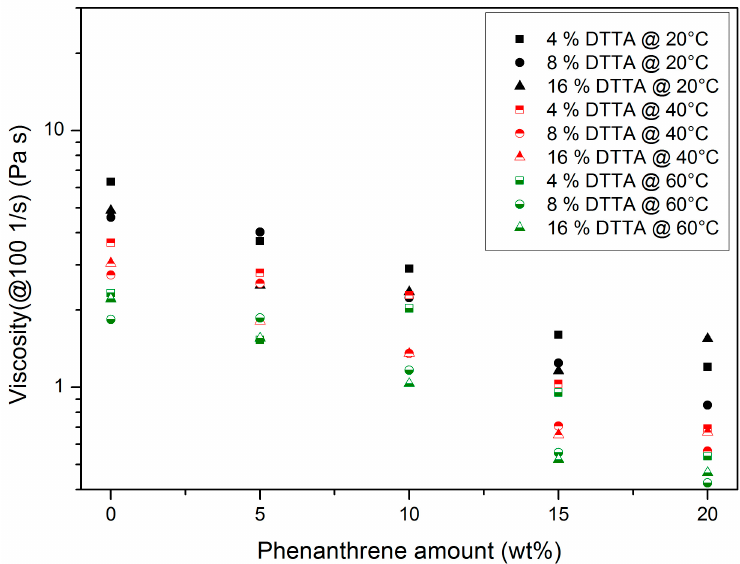
Figure 5. Influence of temperature, DTTA, and phenanthrene content on the viscosity of the mixture at a common shear rate of 100 1/s.